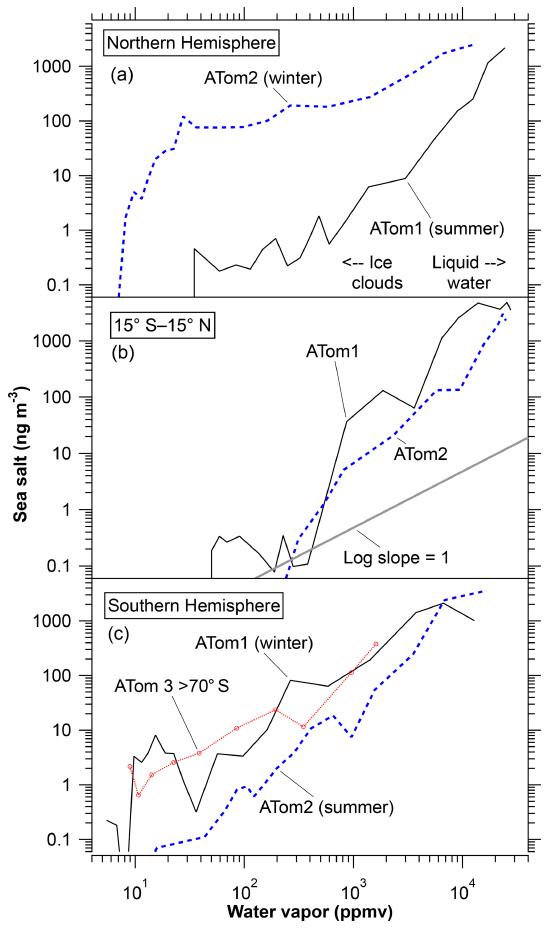
Figure 6. Measured average sea-salt mass concentrations as a func- tion of water vapor. Latitude bands for the Northern and Southern hemispheres are 20 to 65 ◦ except for the labeled data over Antarc- tica. All data except those beyond 70 ◦ S are from the Pacific Ocean side of North and South America. Arrows in panel (a) show approx- imate water mixing ratios above which most clouds are liquid water and below which most clouds are ice. One way to view the graph is to consider water vapor as a vertical scale with wet air at low alti- tudes and dry air at high altitudes. In both hemispheres the winter data show more sea-salt aerosol in the upper troposphere at a given amount of water vapor than either the summer hemisphere or the